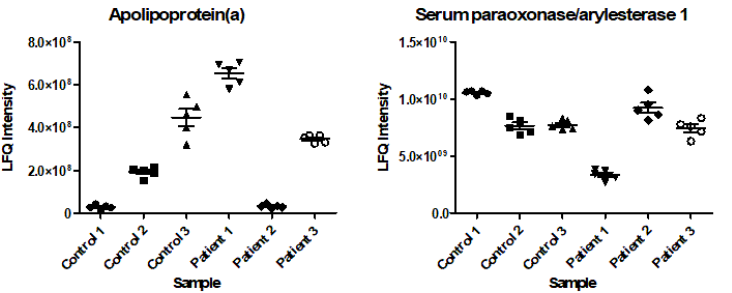
Figure 2. Two of the most distinctive proteins in the cluster analysis: apolipoprotein(a) (F-value 204.99; uniprot-accession code P08519) and serum paraoxonase/arylesterase 1 (F-value 91.62; uniprot-accession code P27169). LFQ intensity is presented as a linear value (mean and standard error of the mean); the individual dots represent the five longitudinally acquired samples for each patient and control.